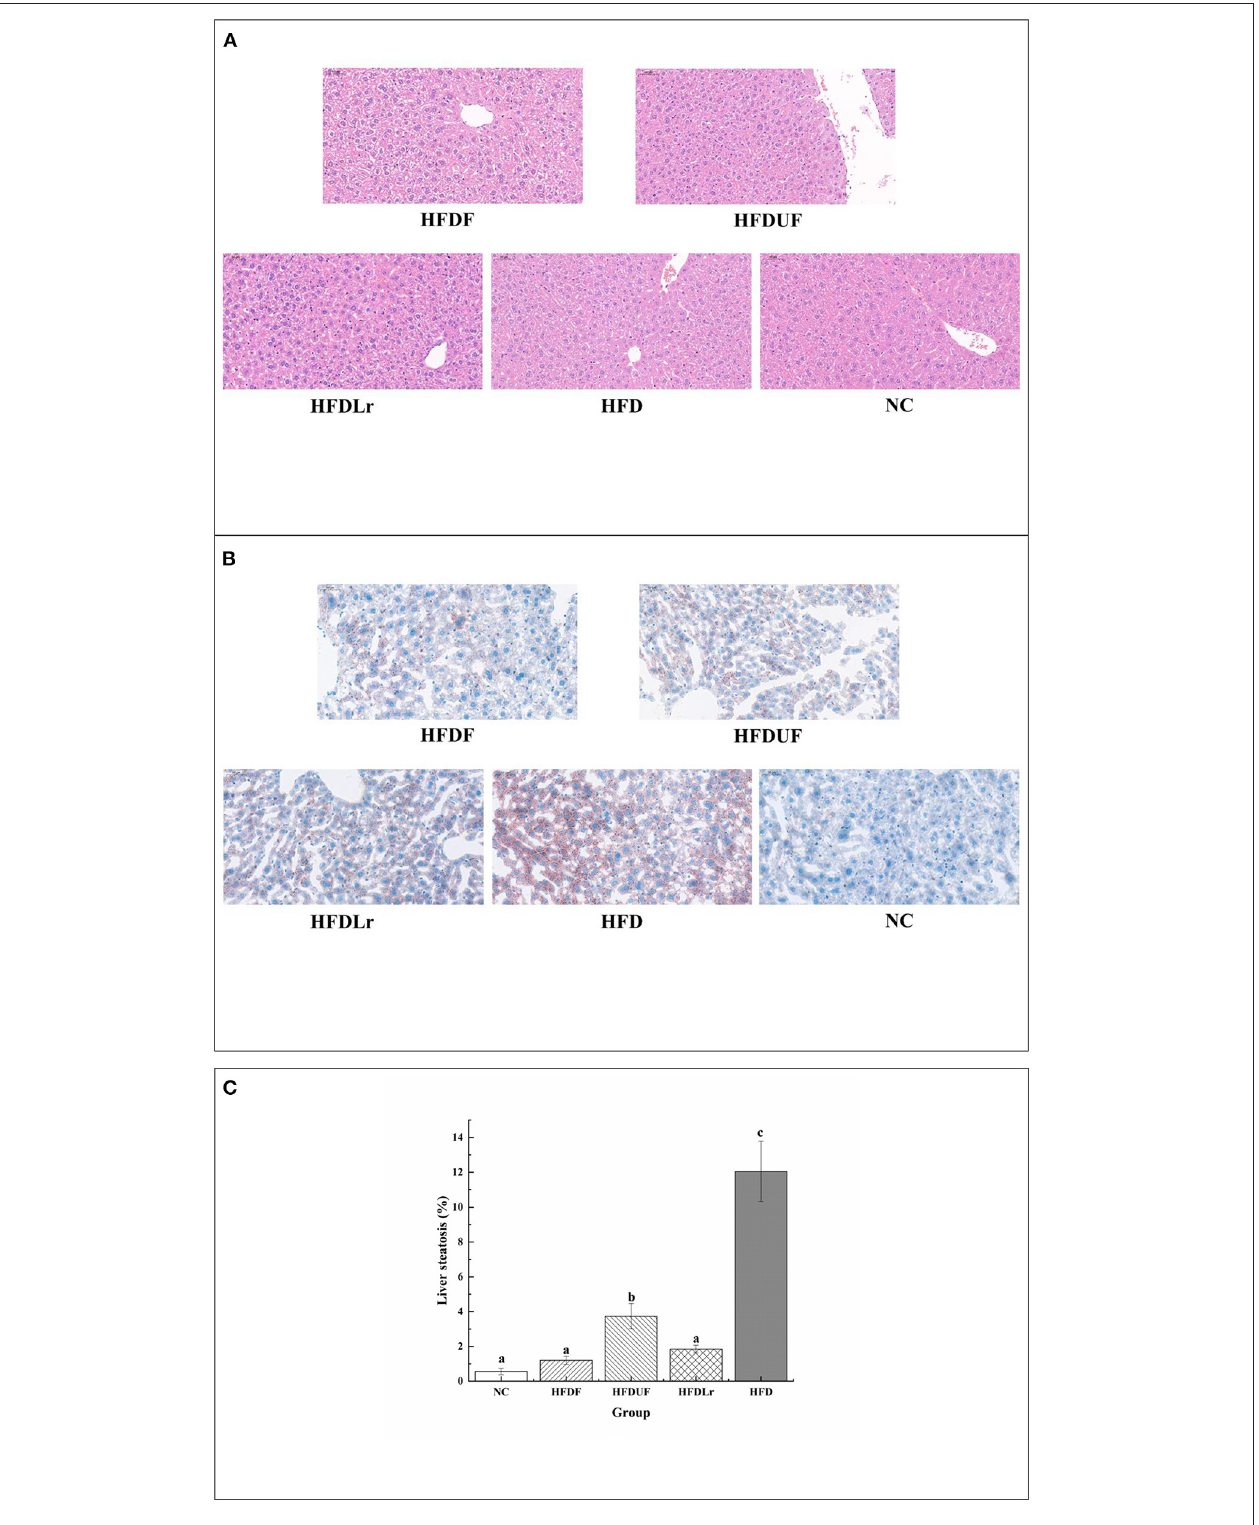
FIGURE 4 | The effect of CSM on liver histopathology. (A) Liver morphology was assessed by H&E staining (200 × magnification). (B) Liver steatosis was assessed by oil-red O staining (200 × magnification). (C) Liver steatosis ratio stained with oil-red O staining. Scale bars: 50 µ m. Data are expressed as the mean ± SD ( n = 3 mice/ group). The statistical differences between groups were analyzed using ANOVA. A p value < 0.05 was considered statistically significant. The superscript letters indicate significant differences between groups.